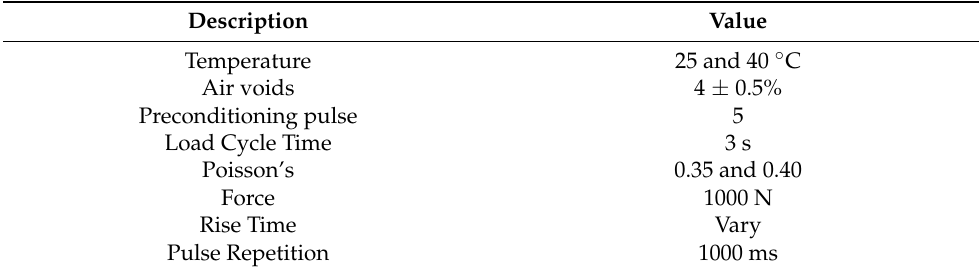
Table 11. Parameters of the resilient modulus test.